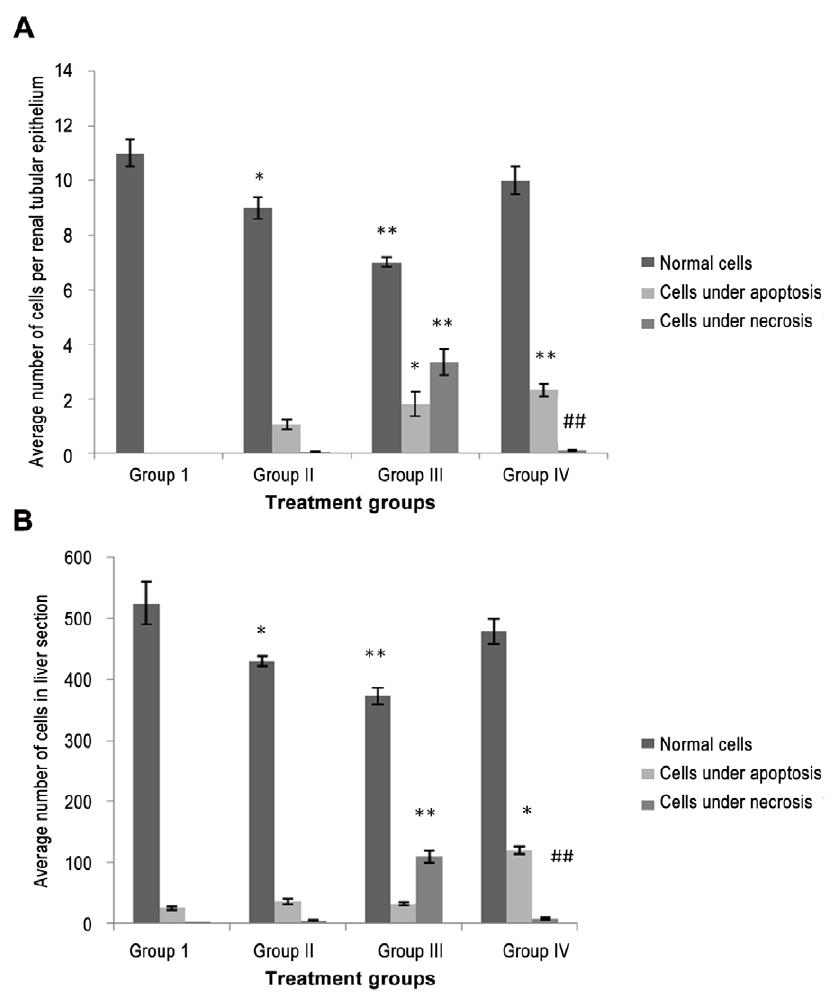
Figure 5. (A): Bar diagram showing average number of cells per renal tubular epithelial cell in kidney section of various groups. All the data have been expressed in mean 6 SEM for five different preparation of each sample. * indicates significantly different from control at p # 0.05. ** indicates significantly different from control at p # 0.01. # indicates significantly different from group III at p # 0.05. ## indicates significantly different from group III at p # 0.01. (B). Bar diagram showing average number of cells in liver section of various groups. All the data have been expressed inmean 6 SEMfor fivedifferentpreparationof eachsample. * indicates significantlydifferentfromcontrol at p # 0.05.** indicates significantly different from control at p # 0.01. # indicates significantly different from group III at p # 0.05. ## indicates significantly different from group III at p #